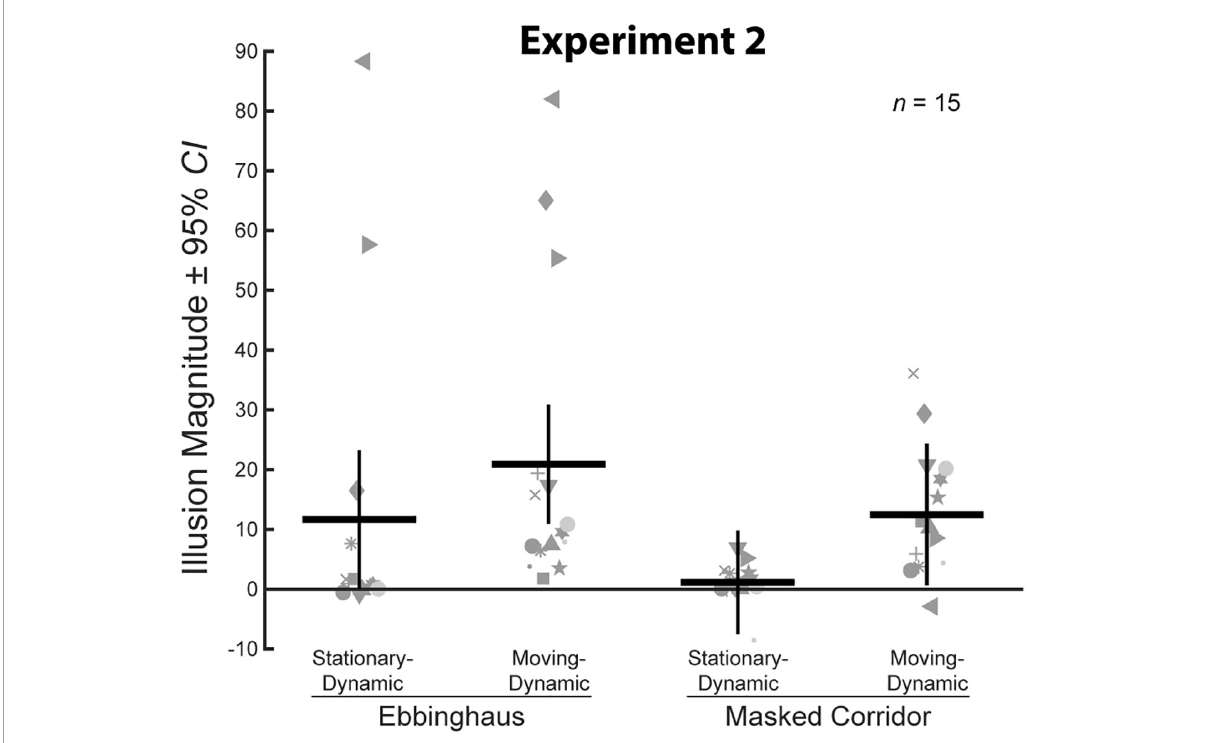
FIGURE5 Illusion magnitudes for the four conditions with a surrounding context in Experiment 2. Conventions are the same as in Figure 3 . Statistical comparisons against zero and across conditions are summarized in Table 2